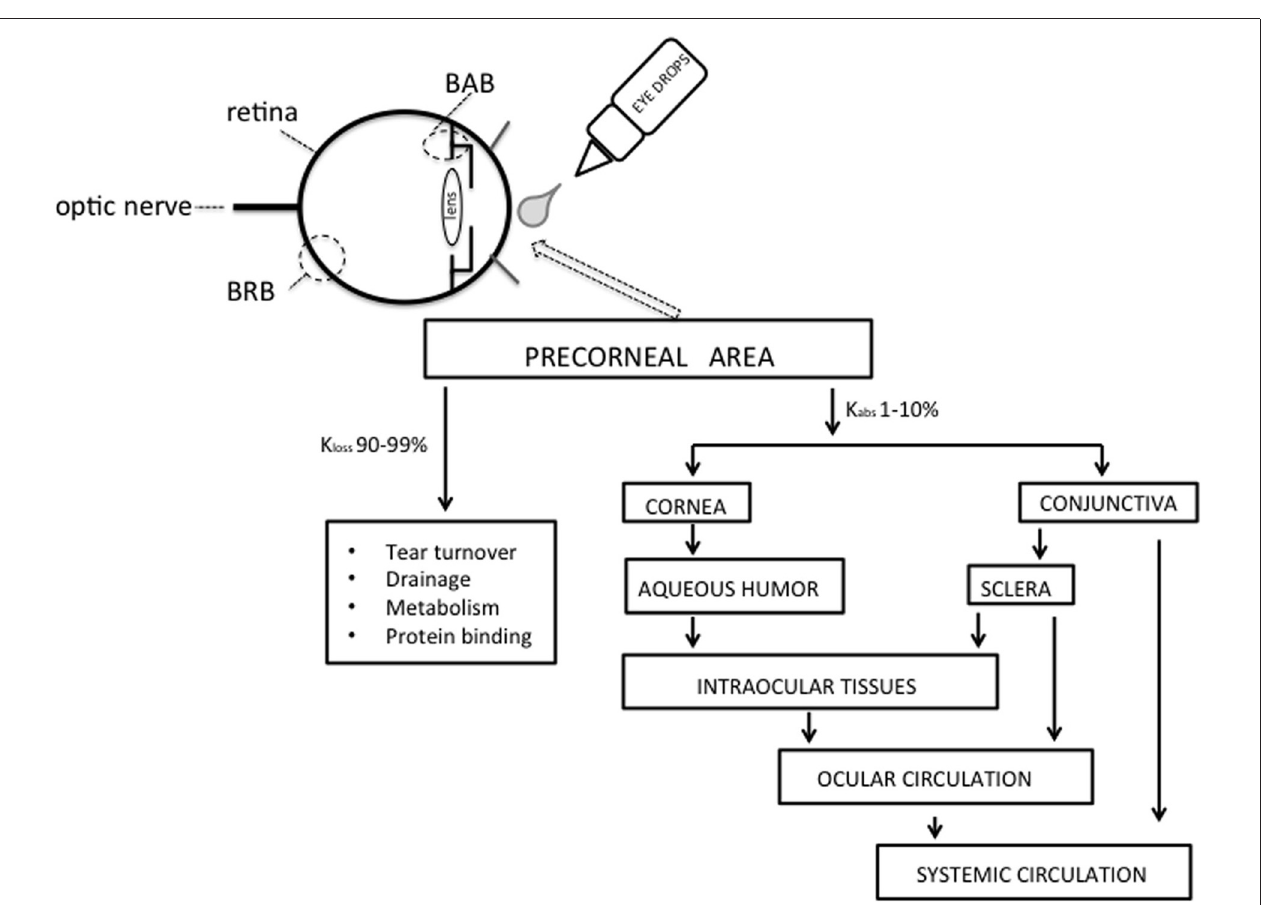
FIGURE 1 | Model showing the movement of drug into the eye after topical administration. BAB, blood-aqueousbarrier; BRB, blood-retinal